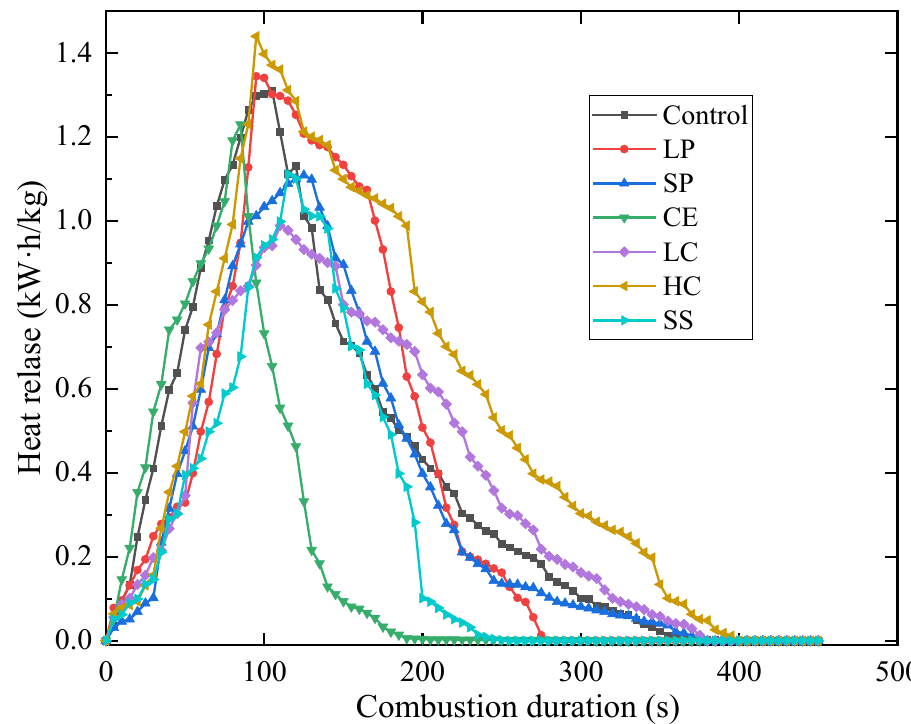
Figure 7. The results of HRR.